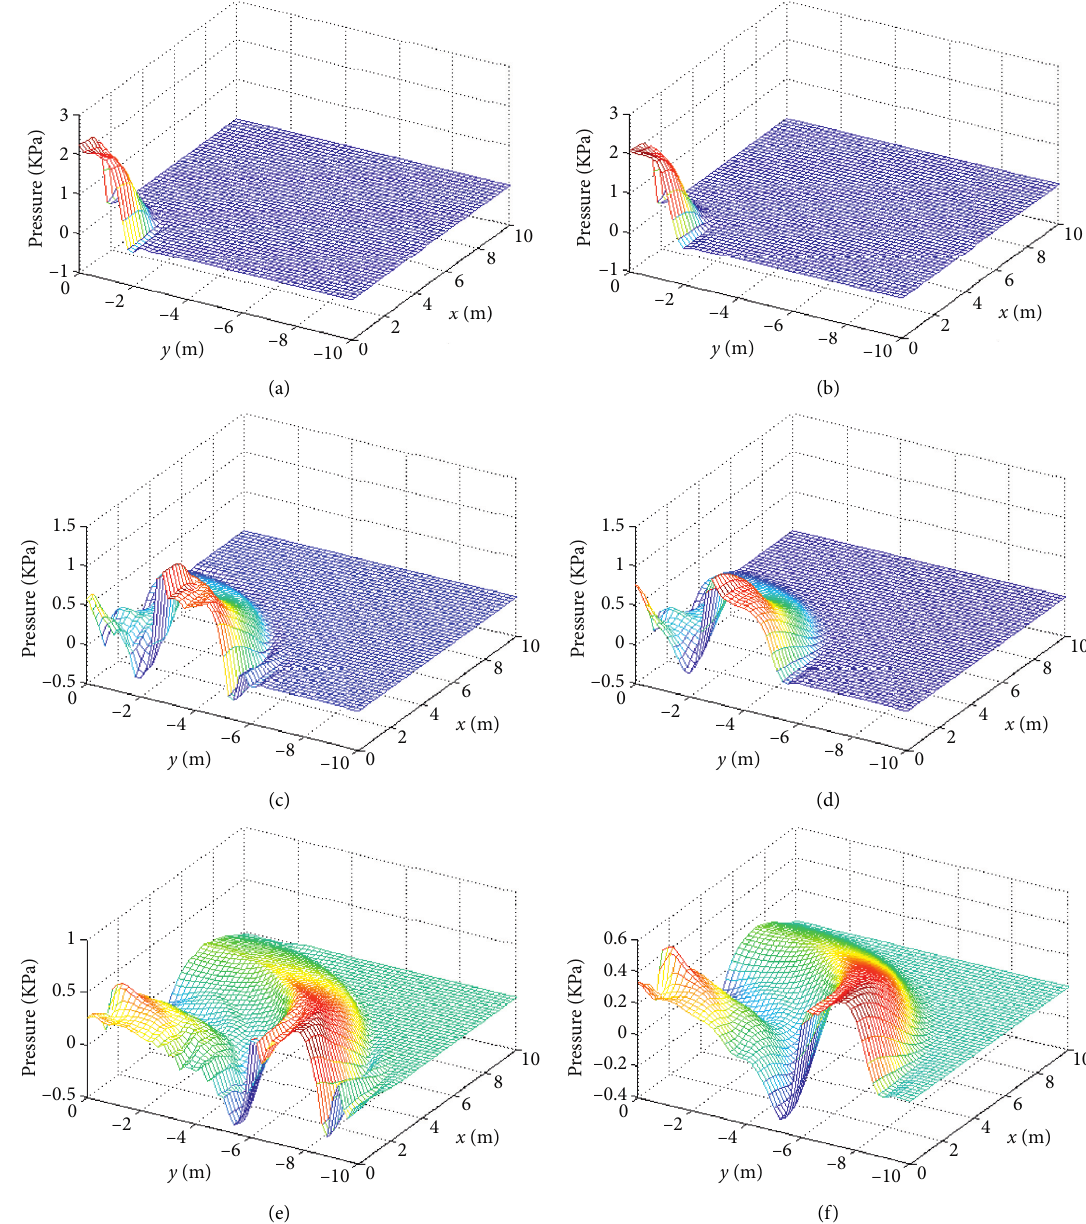
Figure 8: Comparison of the pressure distributions between the Newmark method and the MDGFEM. (a) Newmark method 0.001s, (b) MDGFEM 0.001s, (c) Newmark method 0.003s, (d) MDGFEM 0.003s, (e) Newmark method 0.005s, and (f) MDGFEM